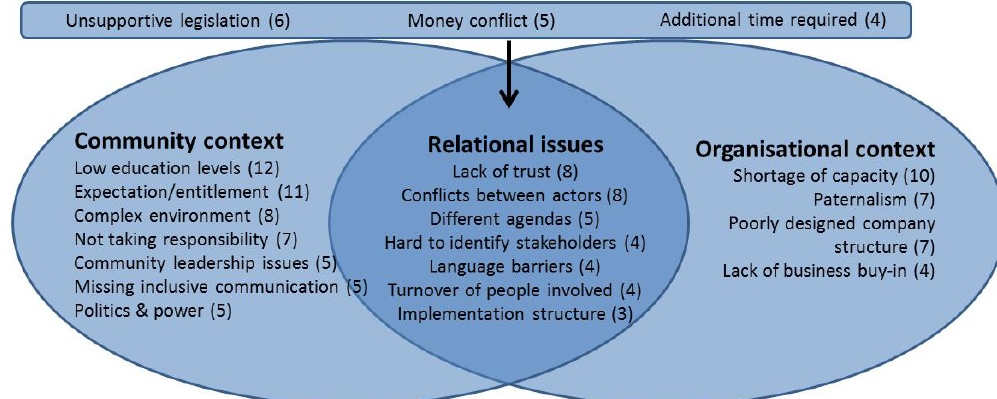
Barriers to transformational community